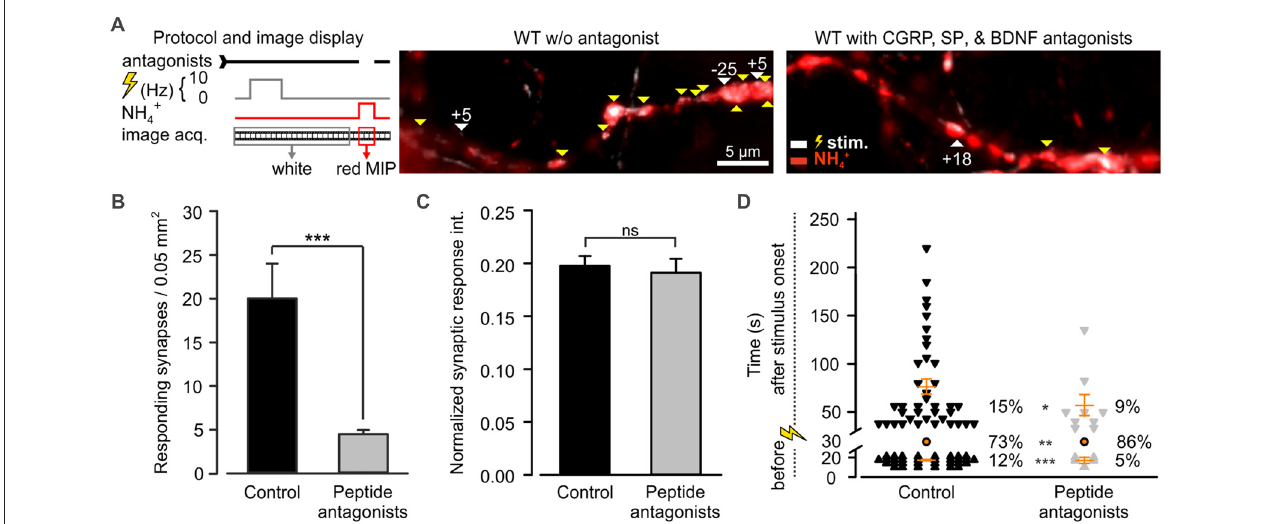
FIGURE 7 | CAPS2 indirectly regulates synaptic transmission. Synaptic transmission measured in WT DRG/SC neurons co-cultures pre-incubated or not (control) with 10 nM olcegepant, 10 µ M L-703,606 oxalate salt hydrate, and 10 µ M cyclotraxin B, inhibiting the receptors for calcitonin gene-related peptide (CGRP) calcitonin receptor-like receptor (CLR), Substance P (SP; NK-1R), and BDNF tropomyosin receptor kinase B (TRKB), respectively. Two co-cultures were generated using two adult mice for DRG neurons and 12 P0 mice for SC neurons, N DRG neurons = 29 and 50, n synapses = 241 and 101 for control and treated neurons, respectively. Error bars are SEM, and Mann-Whitney test was applied, ns = non-significant, ∗ p < 0.5, ∗∗ p < 0.01 and ∗∗∗ p < 0.001. (A) The recording protocol is shown on the left. The images correspond to an overlay of the SypHy MIP over time in DRG/SC neurons acquired prior to (white) and during superfusion with NH 4 Cl (red) in control (left) and inhibition (right) conditions. White vs. red images indicate active vs. SypHy-labeled synapses, respectively. Yellow and white arrows indicate synchronized and uncoupled synapses, respectively. The associated numbers correspond to the time (s) between the stimulus and the response. (B) Average number of active synapses in neurons pretreated with peptide antagonist (gray) or not (black). (C) Average SypHy fluorescence increase in response to electrical stimulation normalized to SypHy fluorescence upon NH 4 Cl application in control and treated neurons. (D) Density dot plot illustrating the time point of activity and the percentage of synapses that were either synchronized to the stimulus or that responded before or after the stimulus. The time point of response of each unsynchronized synapse is indicated by individual symbols whereas all synchronized synapses are indicated by one orange circle. Orange dashes are the average time point of unsynchronized response ±